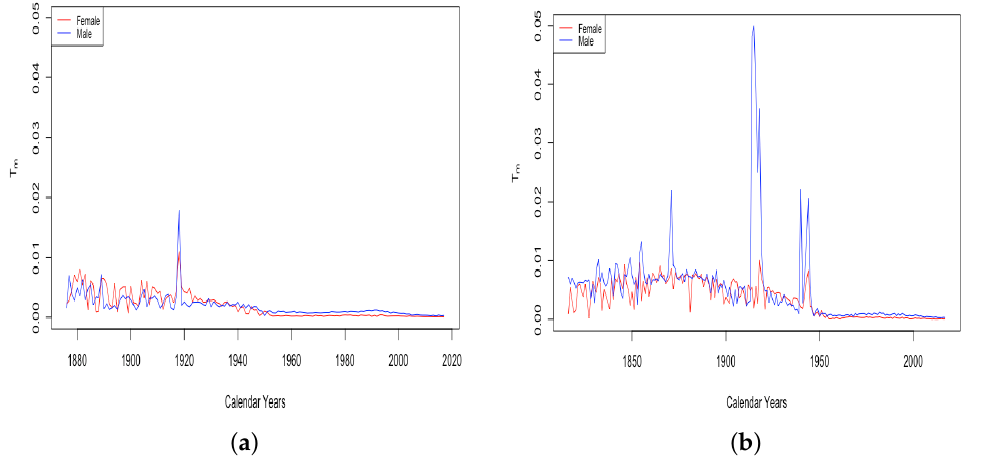
Figure 16. ( a ) The limiting teenage mortality T m for Switzerland, male vs. female. ( b ) The limiting teenage mortality T m for France total population, male vs.